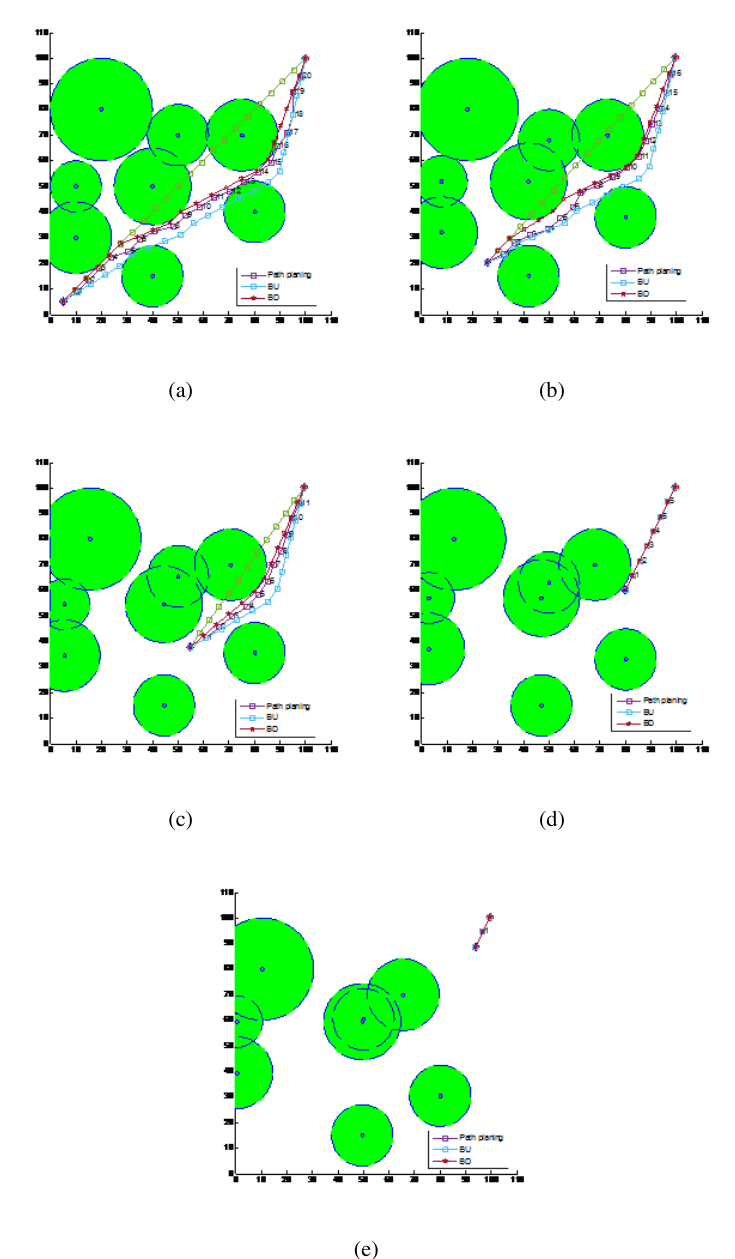
Fig. 12 All threatening obstacles are moving for dynamic path planning: (a) step 0; (b) step 5; (c) step 10; and (d) step